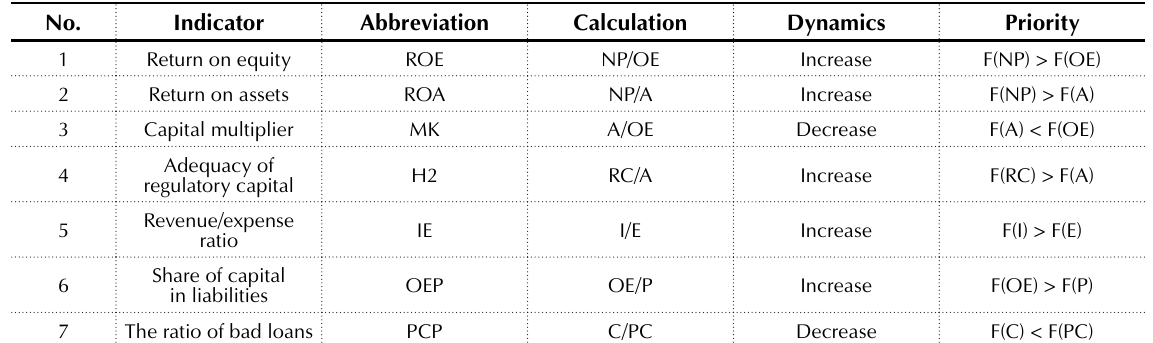
Table 1. Indicators for calculating the dynamic